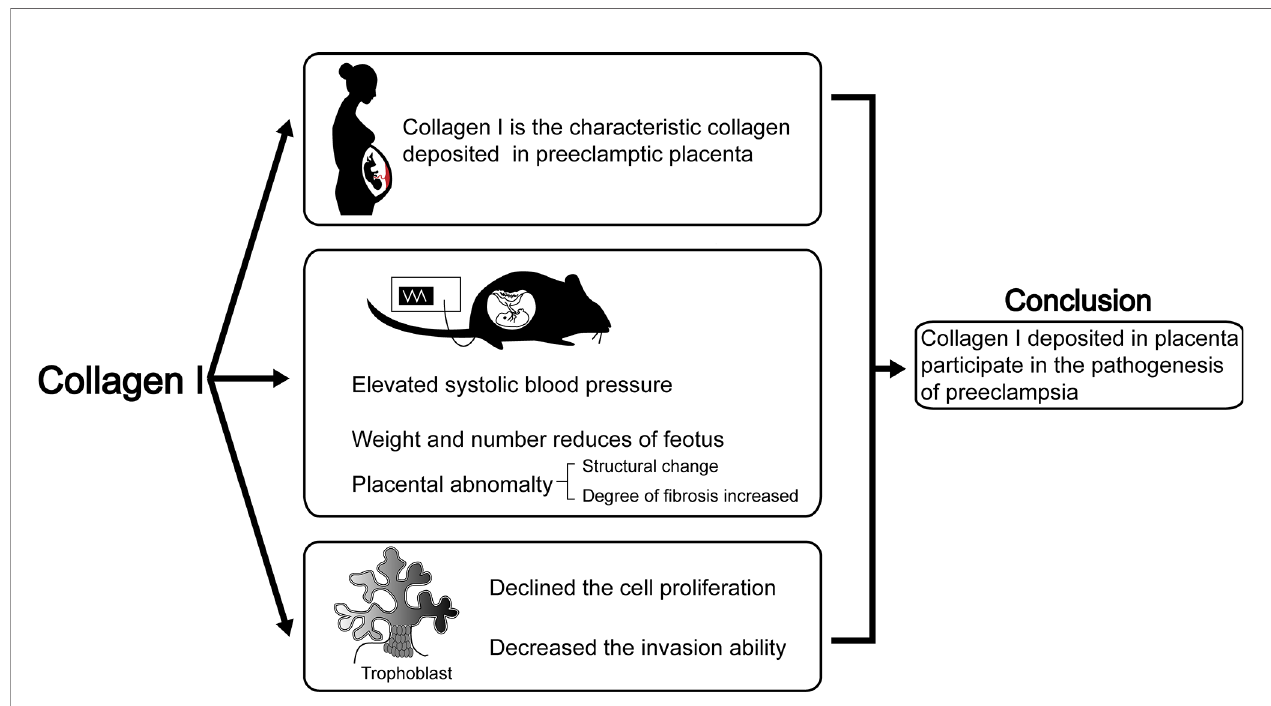
FIGURE 6 | The abstract graphic. Collagen I deposited in placenta participate in the pathogenesis of preeclampsia: Collagen I is the characteristic collagen deposited in preeclamptic placenta. Collagen I administration is associated with suppressed proliferation and invasion of trophoblasts, and with preeclampsia-like symptoms in pregnant